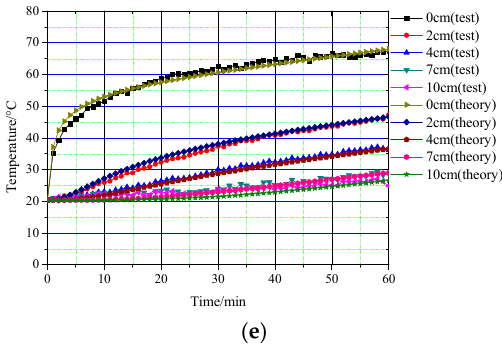
Figure 8. ( a ) Results of theoretical calculation and tests of S1; ( b ) Results of theoretical calculation and tests of S2; ( c ) Results of theoretical calculation and tests of S3; ( d ) Results of theoretical calculation and tests of S4; ( e ) Results of theoretical calculation and tests of S5.